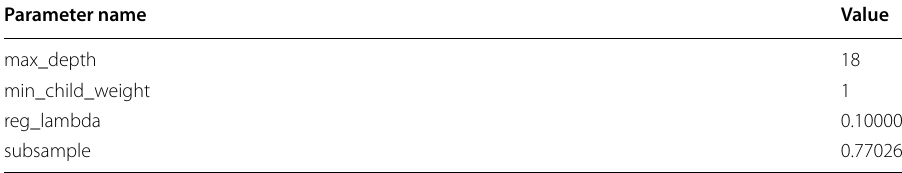
Table 89 Modes of XGBoost tuned hyperparameter values for experiments with the data exfiltration dataset